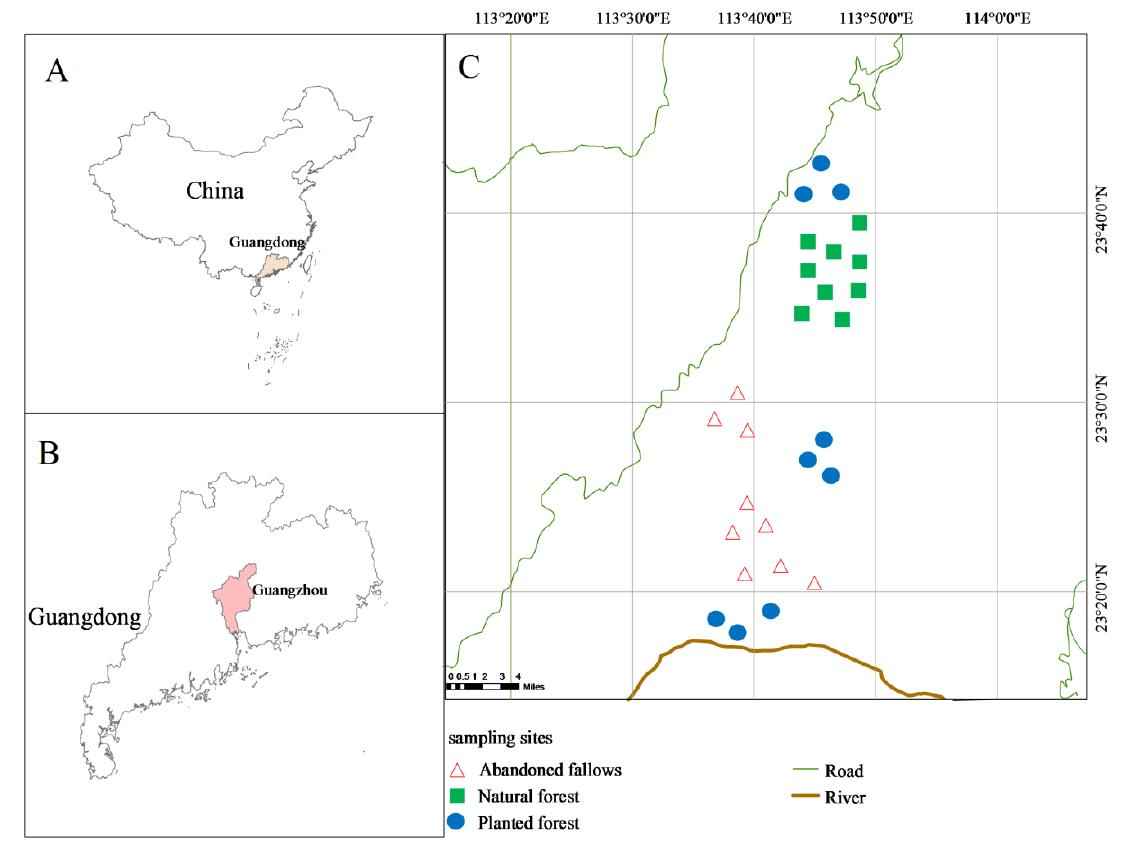
Figure 1. Geographic location of the study area in Guangdong, China ( A , B ) and sampling sites ( C ). Table 1. Stand site characteristics.